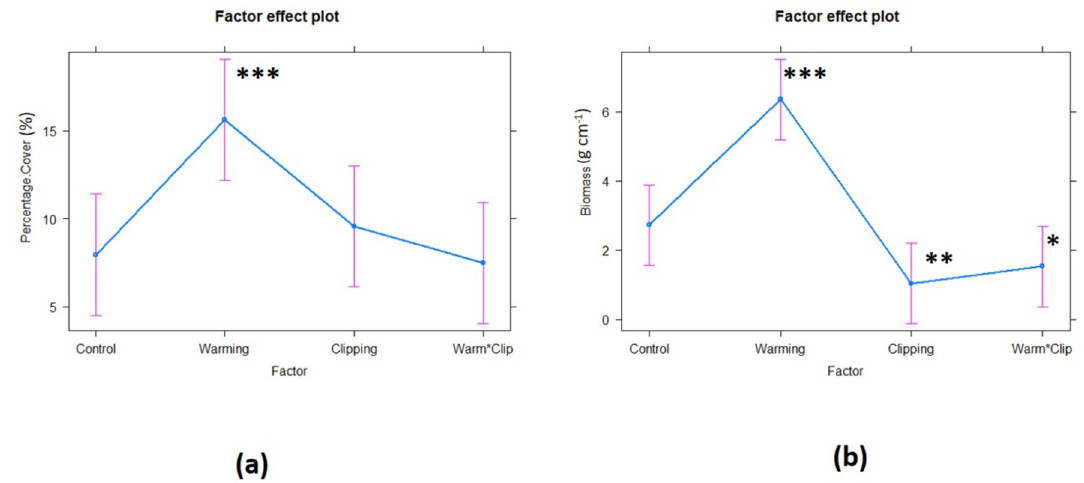
Fig 2. Linear mixed effect model representation of significant effects of each treatment (fixed effect) on percentage cover and biomass. a) Percentage cover was higher in warming plots in comparison to control but warming and clipping treatment significantly had less cover of species. b) greater biomass of all species in warming treatment in comparison to control and other treatments, suggested that under passive heating, plants tend to increase their vegetative growth. The significant codes ‘ ��� ’ 0.001 ‘ �� ’ 0.01 ‘ � ’ 0.05 ‘.’ 0.1 ‘ ‘ 1. red dot = 0 . 1